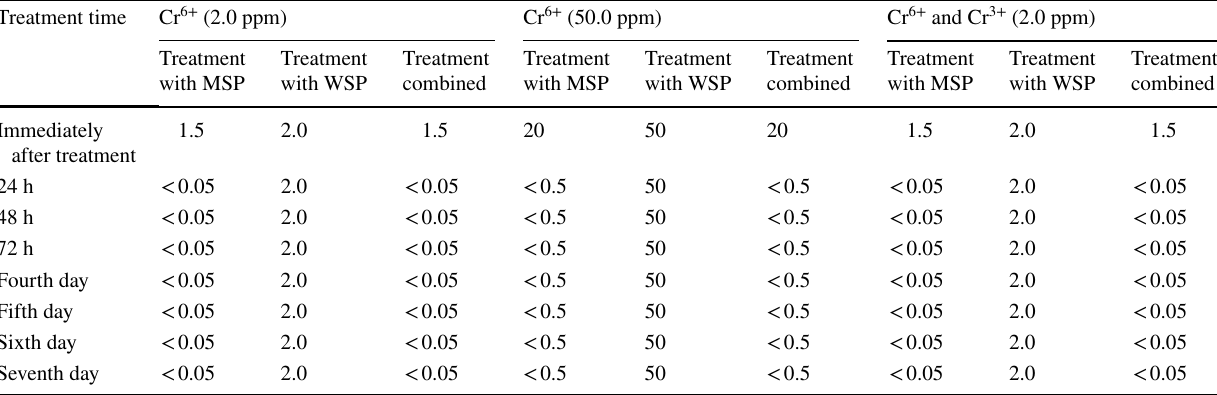
Table 4 Effectiveness of bio-sorbant materials to remove Cr + from LPEW Treatment time Cr 6+ (2.0